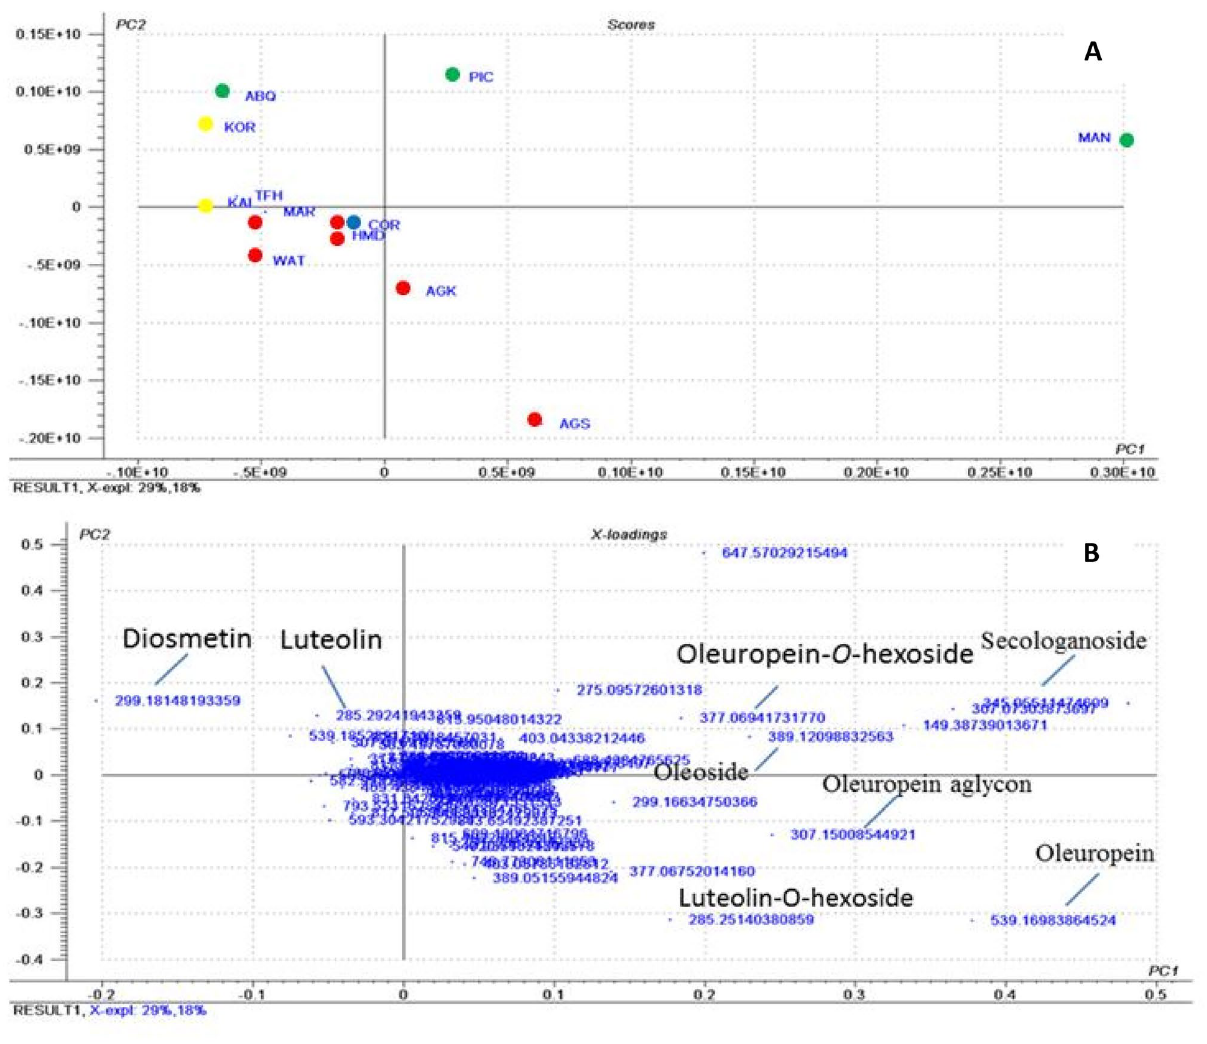
Figure 3. PCA analysis of different cultivars of olive leaves collected in autumn derived from the negative ionization mode HPLC/ MS data ( m/z 100–1000); showing ( A ) a PCA score plot of metabolites of olive leaves and ( B ) a loading plot of metabolites of olive leaves. AOK Agizi Okasi, ASH Agizi Shami, HMD Hamed, MRK Maraki, TFH Toffahi, WAT Watiken, MAN Manzanillo, PIC Picual, ABQ Arbequina, KAL Kalamata, KOR Koroneiki, COR Coratina. Where, Egyptian cultivars in red, Spanish cultivars in green, Greek cultivars in blue and Italian cultivars in